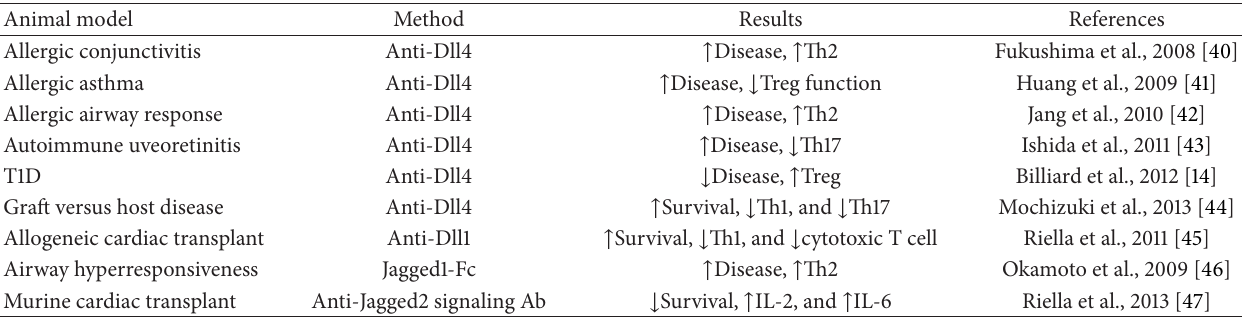
Table 3: Notch and animal models of immune mediated